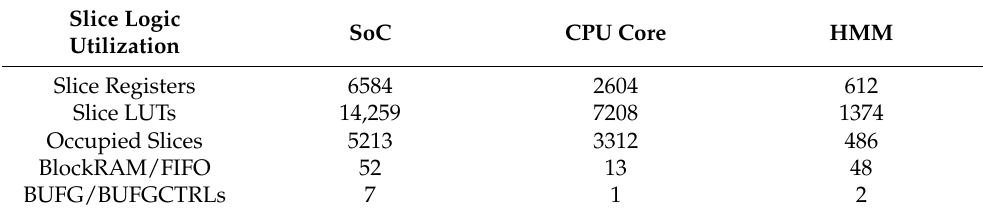
Table 7. The FPGA resources used for the security-enhanced embedded